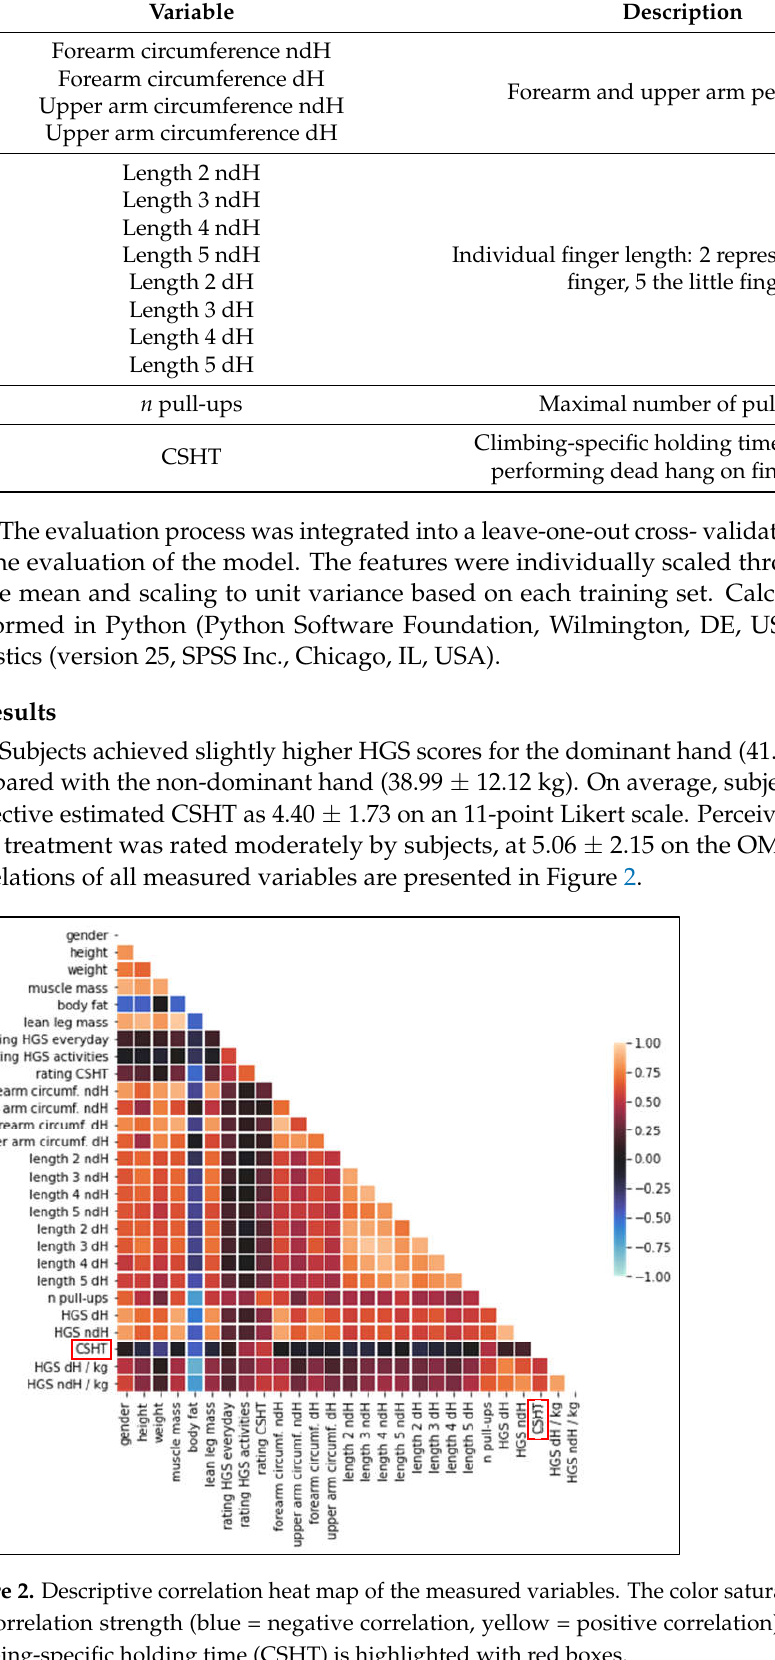
Table 2. Regressors of the multivariate model to predict the maximal climbing-specific holding time (CSHT) for dominant (dH) and non-dominant (ndH) hands. In addition, the regression coefficients, B; standardized coefficients, β; standard error, SER (quality of the estimate); and p -values of the respective predictors are shown. HGS = hand grip strength. ndH R 2corr = 0.63